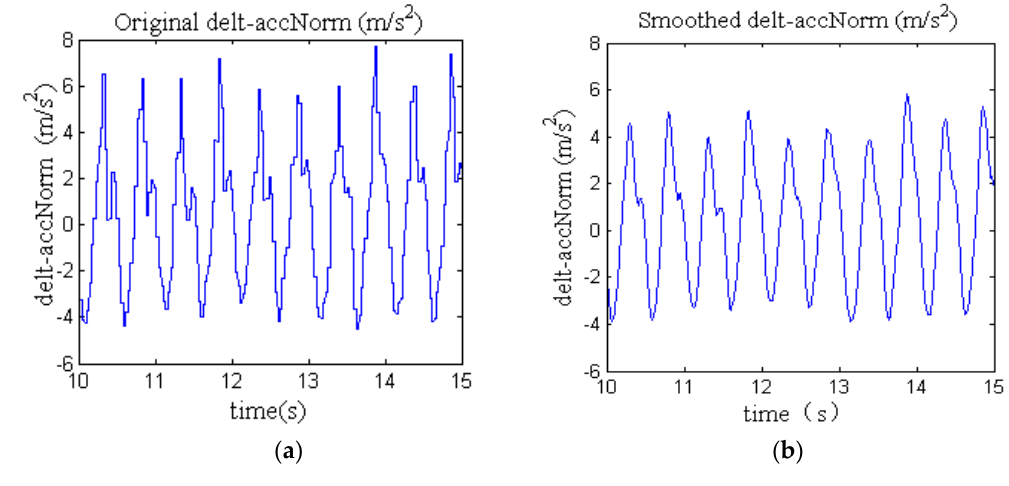
Figure 3. Original and smoothed delt-accNorm.